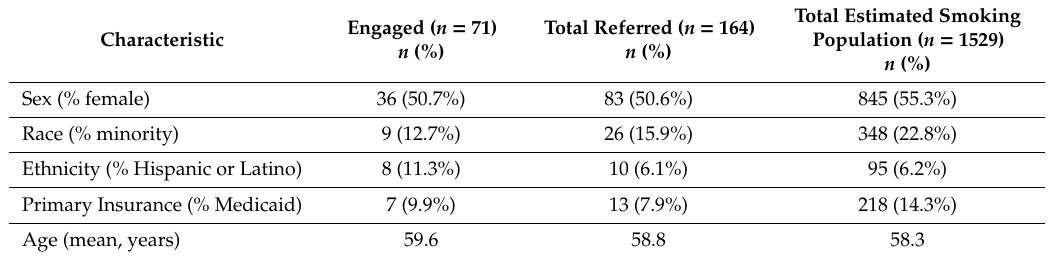
Table 1. Characteristics of all documented smokers in the Lurie Cancer Center patient population and of the subgroups of smokers referred and engaged in